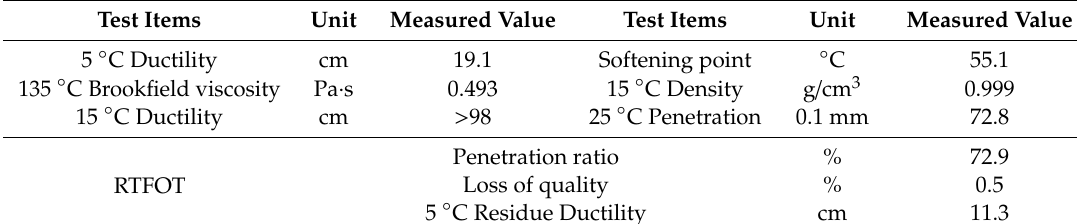
Table 1. A-70 bitumen technical indicators. Table 1. A ‐ 70 bitumen technical indicators